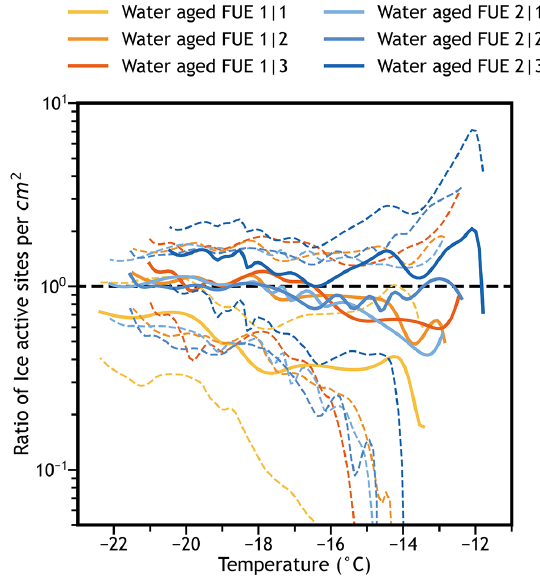
Figure 7. Comparison of individual water aged cumulative n s spec- tra to the remaining combined water aged cumulative n s spectra. Each curve is a difference spectrum of one of the six experiments di- vided by the remaining five experiments combined (solid lines) with bootstrapped tskew 99% confidence intervals (dotted lines). The ex- periment shown in goldenrod (1 | 1) is statistically significantly dif- ferent from the other five experiments and is therefore deemed an